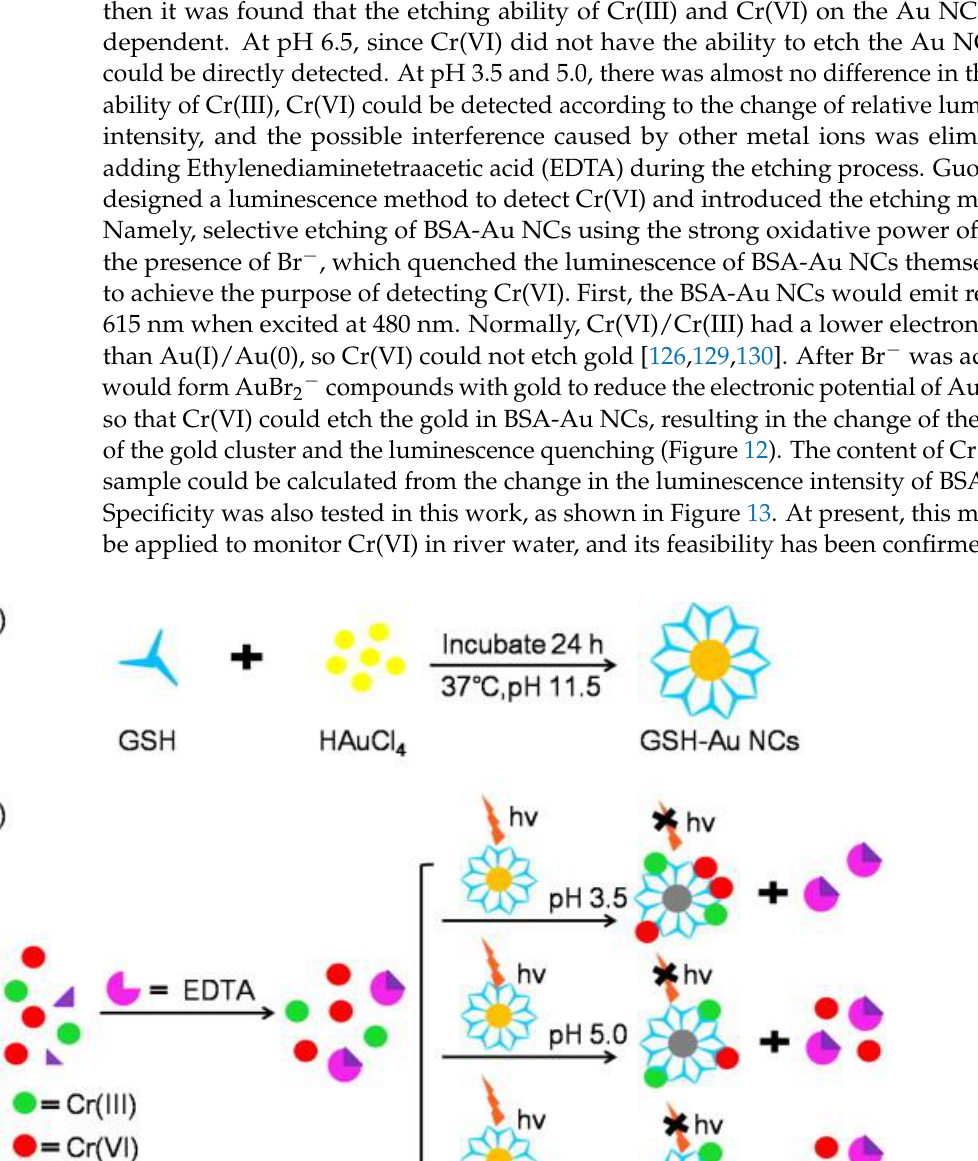
Figure 12. Mechanism of Cr(VI) selectively etching BSA-Au NCs and quenching their luminescence. Reprinted with permission from Ref. [32], Copyright © 2016 The Royal Society of Chemistry. Figure 13. Specific determination of Cr(VI)-etched BSA-Au NCs. ( A ) Luminescence emission spectra of BSA-Au NCs after adding different ions. ( B ) The degree of luminescence change of BSA-Au NCs after adding different ions (the inset is the imaging under UV light). Reprinted with permission from Ref. [32]. Copyright © 2016 The Royal Society of Chemistry.